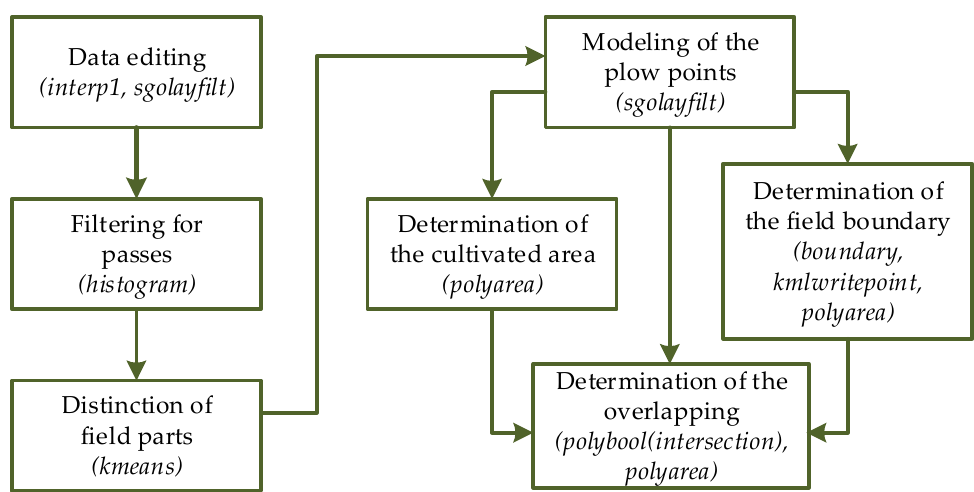
Figure 4. Flowchart of the main data analysis steps. The utilized MATLAB functions are also indicated.